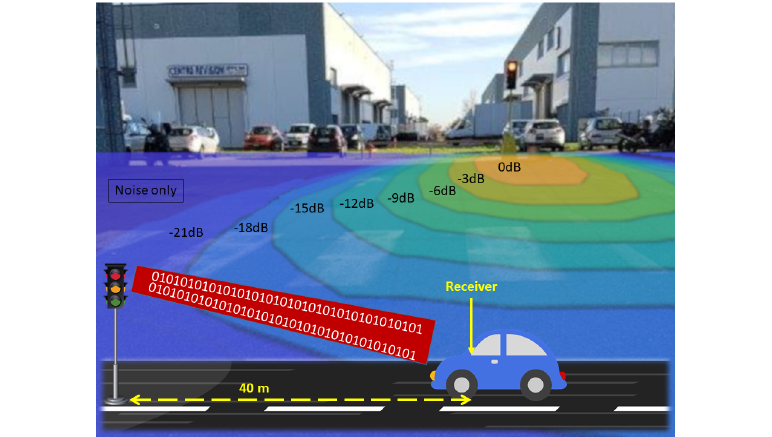
Figure 4. Experimentation of I2V link using visible light communication